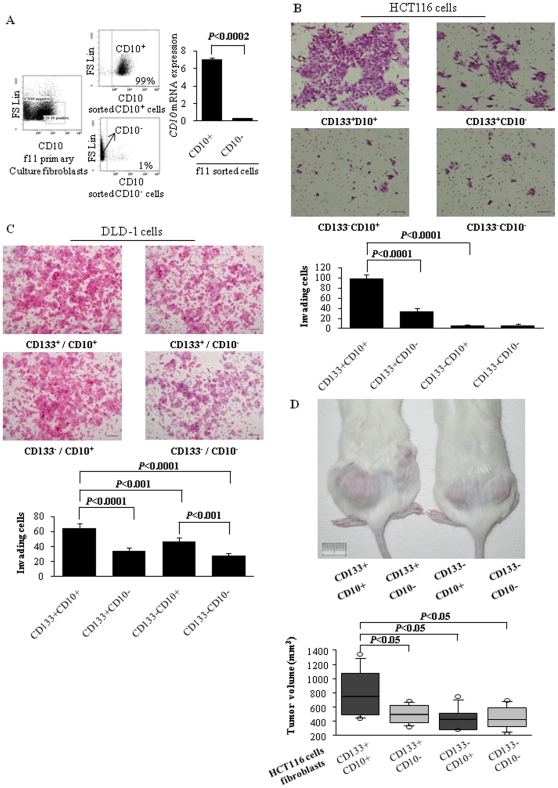
CD10+ fibroblasts enhance the in vitro invasion and in vivo tumor growth of CD133+ cancer cells.(A) Analysis of primary cultures of colon cancer-associated fibroblasts (left panel) and reanalyses of sorted CD10+ cells (middle upper panel) and CD10− cells (middle lower panel). The CD10 mRNA levels in the sorted CD10+ and CD10− fibroblasts were measured by qRT-PCR (right panel). (B, C) The invasiveness of CD133+ and CD133− cancer cells cocultured with CD10+ or CD10− fibroblasts was evaluated. Representative photographs are shown (B, HCT116 cells; C, DLD-1 cells). Scale bars = 100 µm. CD10+ fibroblasts enhance the invasiveness of CD133+ cancer cells significantly more than CD10− fibroblasts (P<0.0001). (D) The effects of CD10+ and CD10− fibroblasts on in vivo tumor growth were evaluated at 4 weeks after cotransplantation of CD133+ or CD133− HCT116 cancer cells and CD10+ or CD10− fibroblasts into SCID mice (n = 6 for each group). Representative photographs are shown (upper panel). Scale bar = 1 cm. CD10+ fibroblasts enhance the tumor growth of CD133+ HCT116 cancer cells significantly more than CD10− fibroblasts (P<0.05; lower panel). Data represent means ± SD.